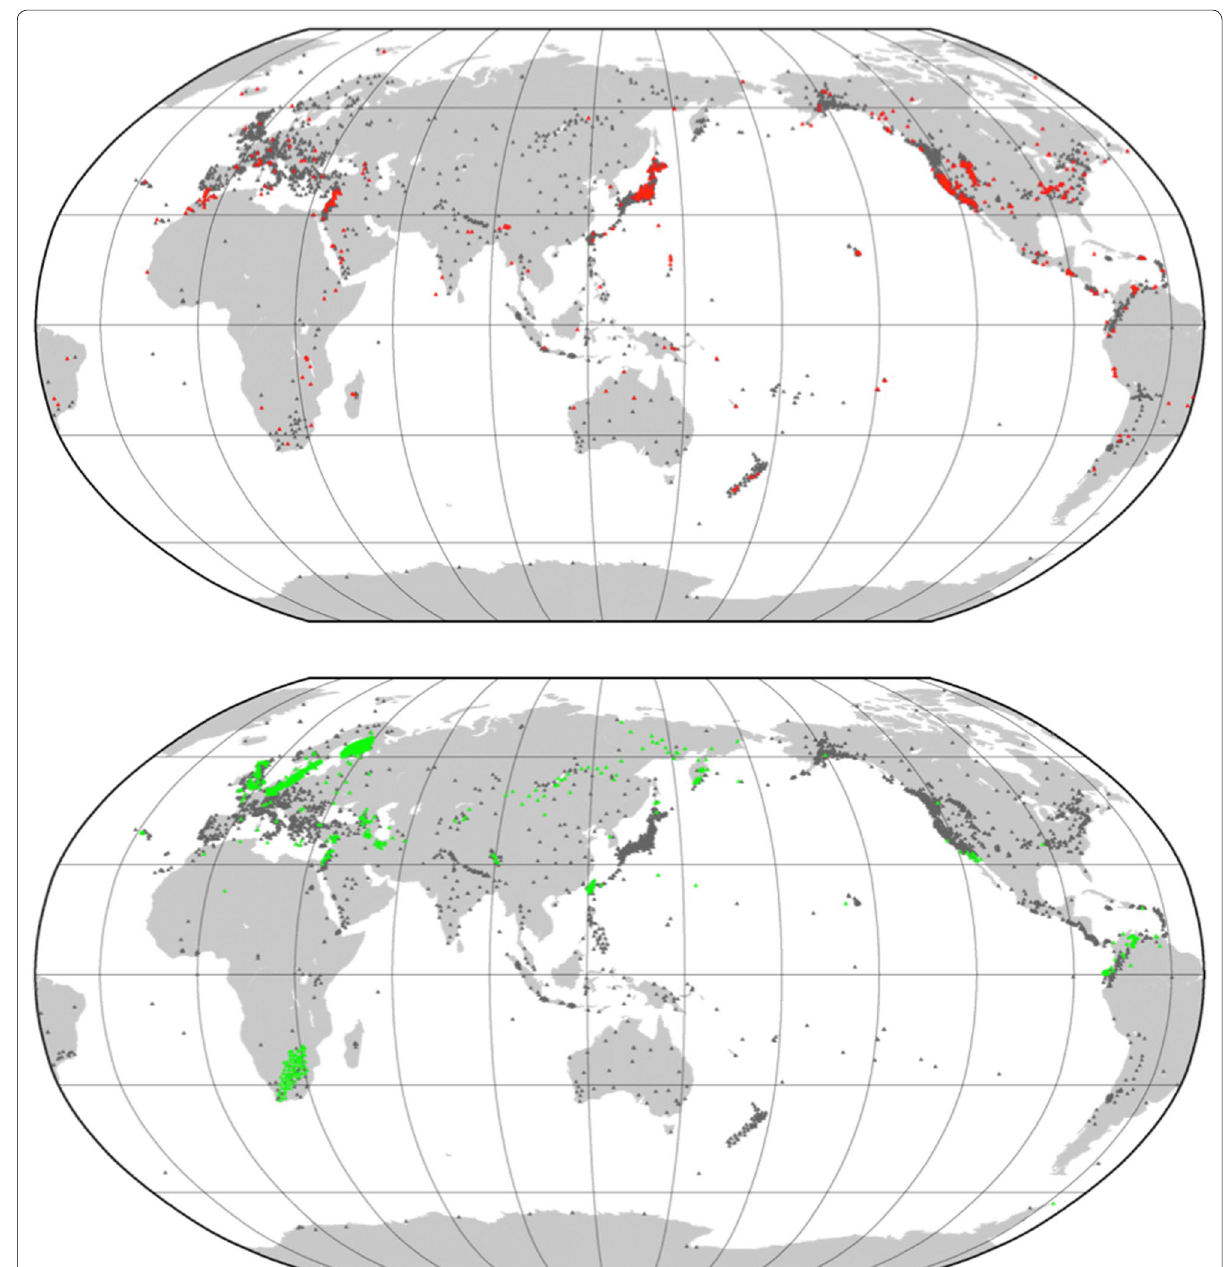
Fig. 15 Background information for Fig. 14: the upper map shows (in red) the stations that reported to the original Bulletin in 1995 but not during 1997–1998; the bottom map shows (in green) the station that were added to the rebuilt ISC Bulletin during 1997–1998. Regions of lost and gained stations do not